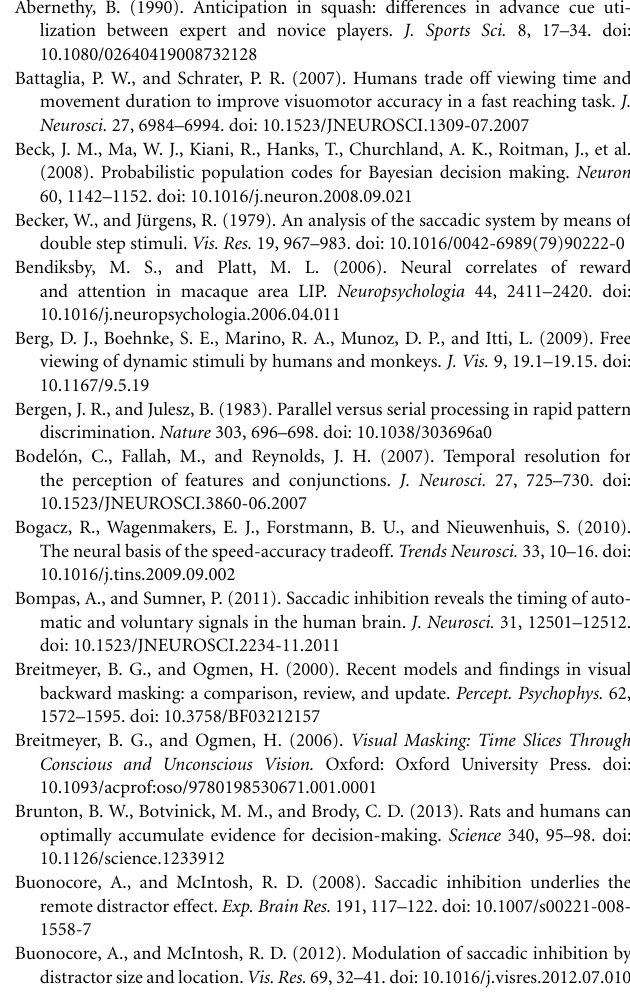
FIGURE 7 | Speed-accuracy curves in the compelled-saccade task. (A) Percentage of correct responses as a function of RT for monkeys S (left) and G (right), computed from the same experimental data shown in Figure 1 . Trials were sorted according to RT, regardless of gap, using bins with a 40ms width sliding in steps of 2ms. Gray shades indicate ± 1 SE based on binomial statistics. (B) RT distributions for correct (blue) and incorrect (magenta) choices for each monkey, based on the same bins used in (A)